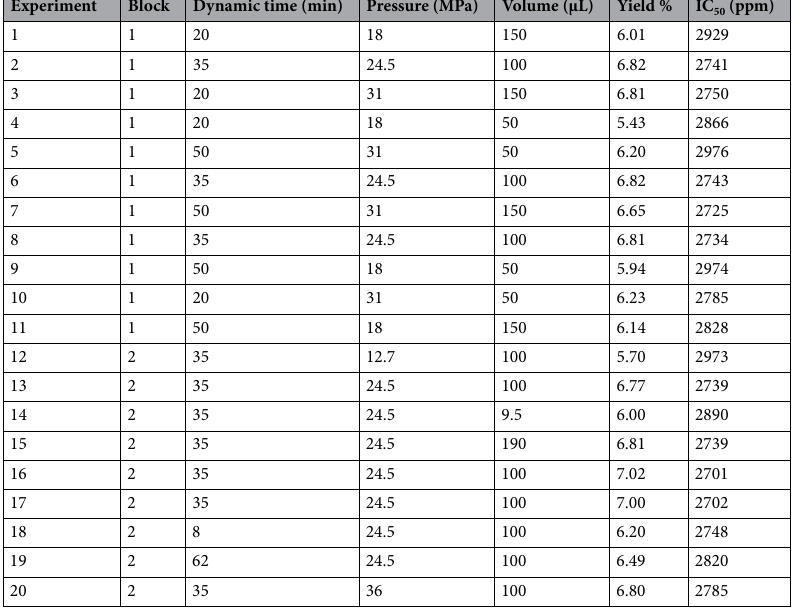
Table 1. Design matrix and the responses for central composite blocked cube-star